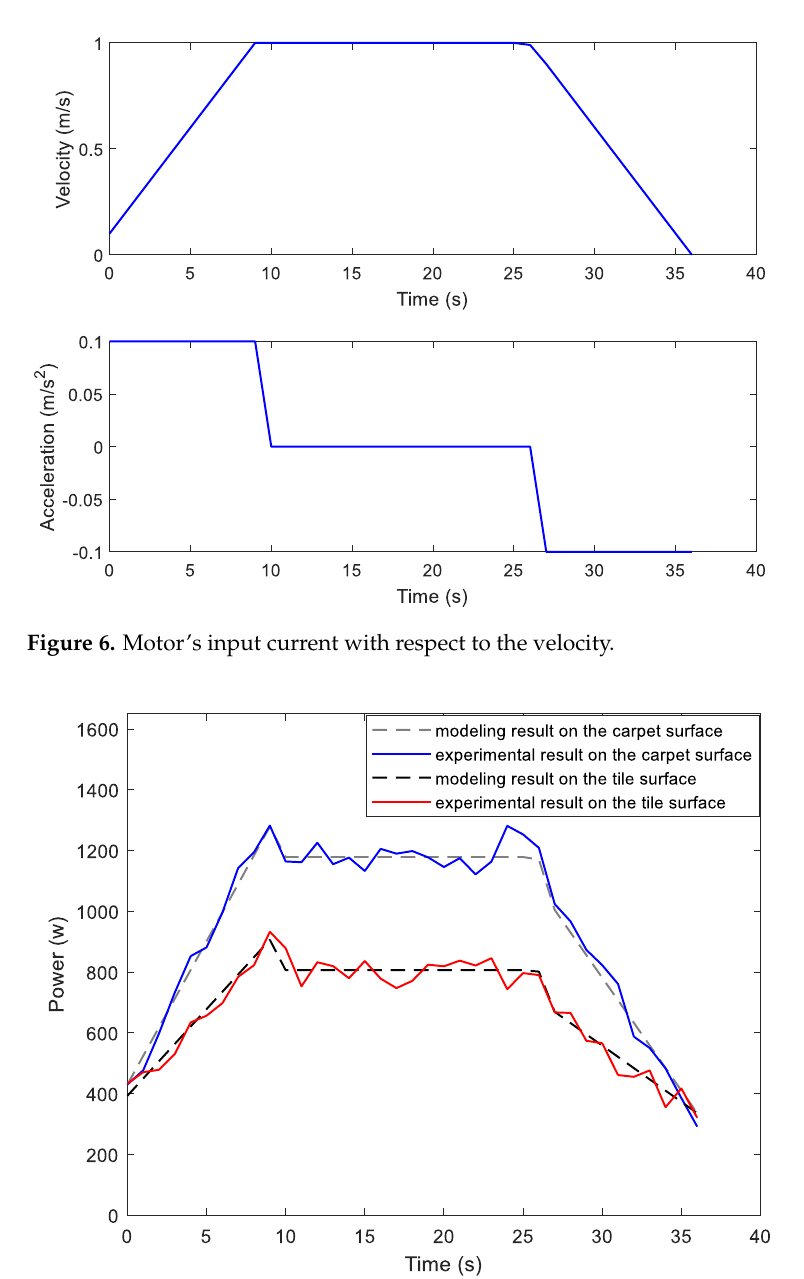
Figure 5. The prototype of the developed Forbot.